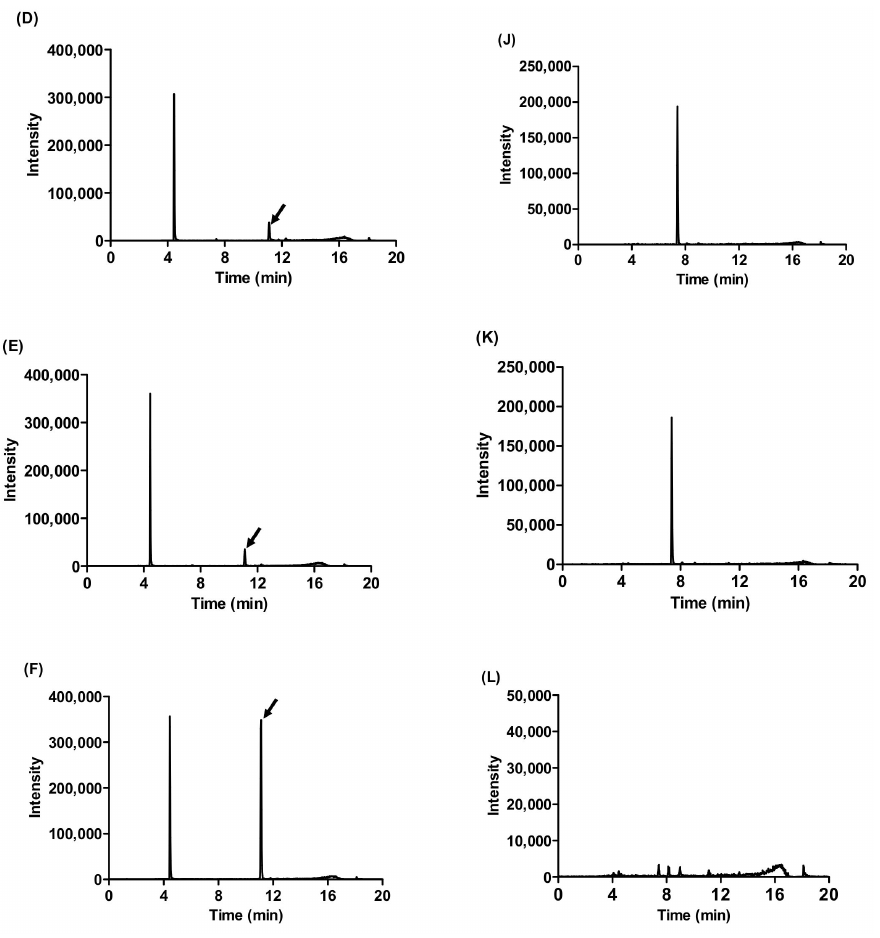
Figure 1. Chromatograms of ginsenoside Rd and Rb1 derived from the fermented wild ginseng extract using LC / MS. Detection of Rd ginsenoside: ( A ) blank (SIR: 969.7 m / z ), ( B ) ginsenoside Rd standard (SIR: 969.7 m / z ), ( C ) the wild ginseng extract (SIR: 969.7 m / z ), ( D ) the autoclaved wild ginseng extract (SIR: 969.7 m / z ), ( E ) 1 day (SIR: 969.7 m / z ) and ( F ) 14-day (SIR: 969.7 m / z ) of fermented wild ginseng extract. Detection of ginsenoside Rb1: ( G ) blank (SIR: 1132.0 m / z ), ( H ) ginsenoside Rb1 standard (SIR: 1132.0 m / z ), ( I ) the wild ginseng extract (SIR: 1132.0 m / z ), ( J ) the autoclaved wild ginseng extract (SIR: 1132.0 m / z ), ( K ) 1-day (SIR: 1132.0 m / z ) and ( L ) 14-day (SIR: 1132.0 m / z ) of fermented the